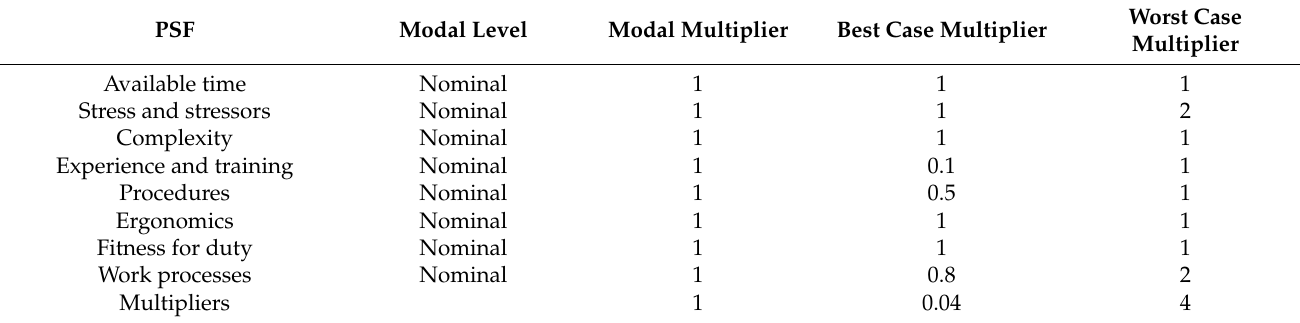
Table 6. Performance shaping factors (PSFs) and range for associated